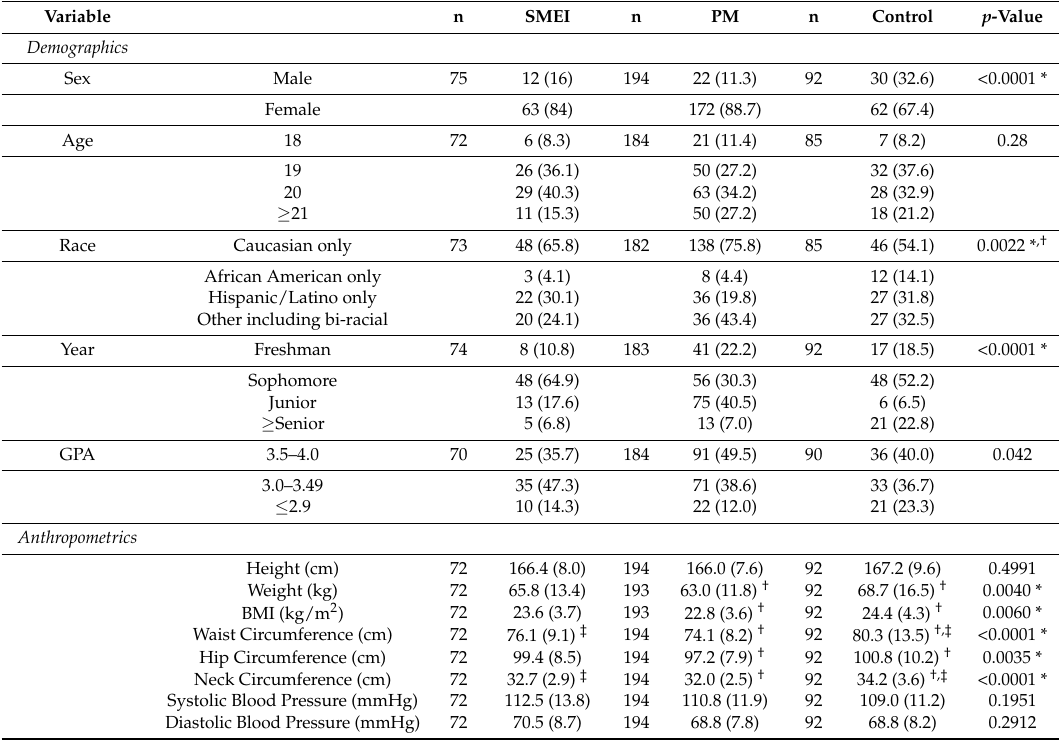
Table 1. Baseline demographics and anthropometrics of Social Marketing and Environmental Interventionists (SMEI), peer mentors (PM), and control. GPA: Grade point average; BMI: Body Mass Index. Variable n SMEI n PM n p